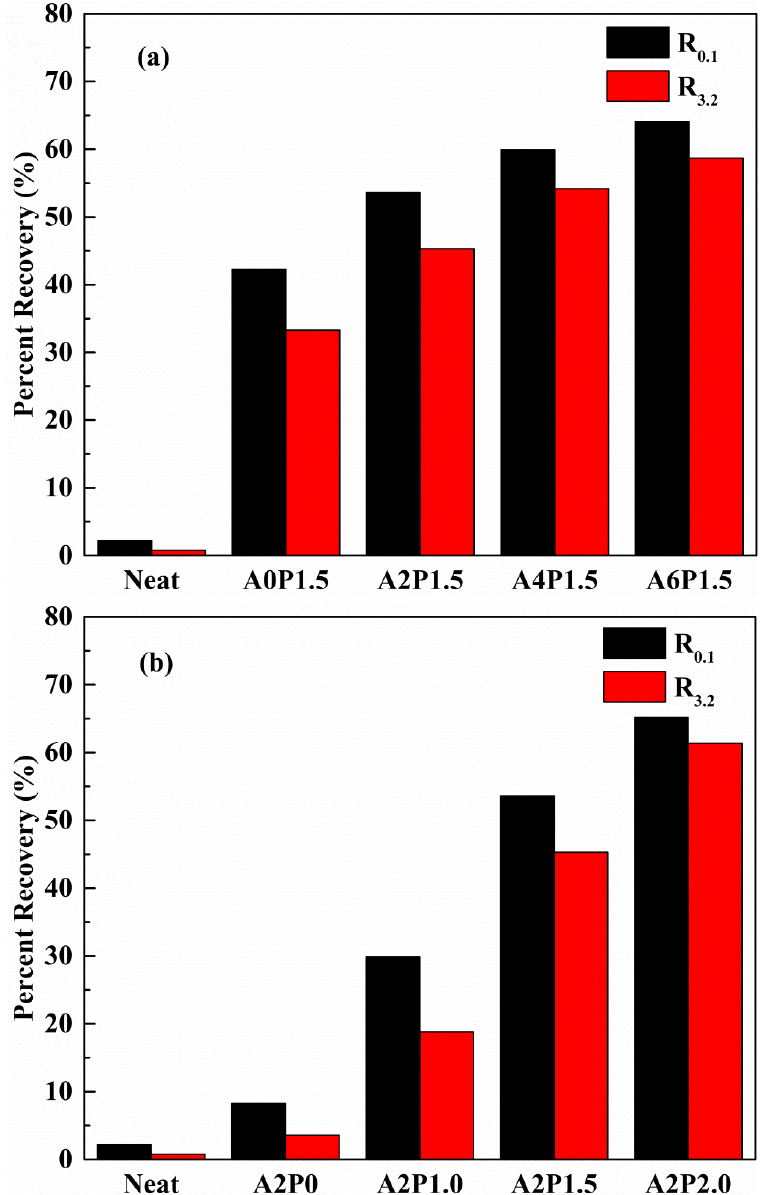
Figure 11. The R of composite modified binders under 0.1 kPa and 3.2 kPa at 60 °C: ( a ) composite modified binders with various contents of APAO; ( b ) composite modified binders with various contents of PPA.